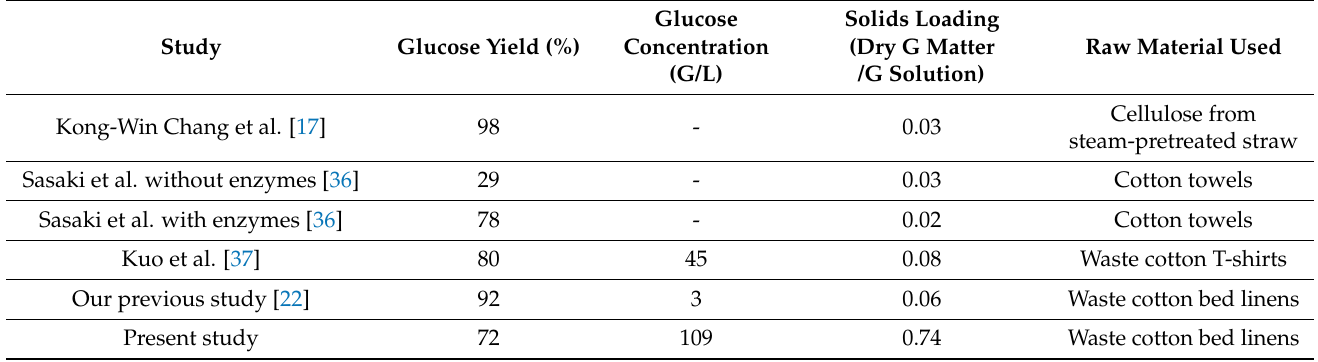
Table 1. Reported yields, product concentrations, and raw material solids loadings from studies producing glucose from cellulose and cotton waste textiles, including the present